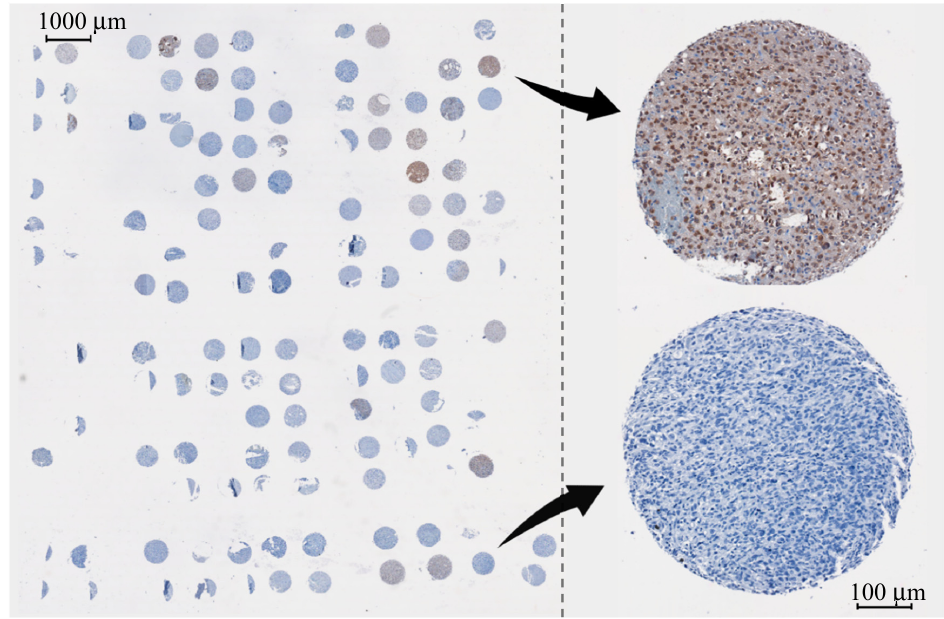
Figure 1. Overview of the tissue microarray with IDH1 staining, with focus on a mutated core (brown) and wildtype core (blue).